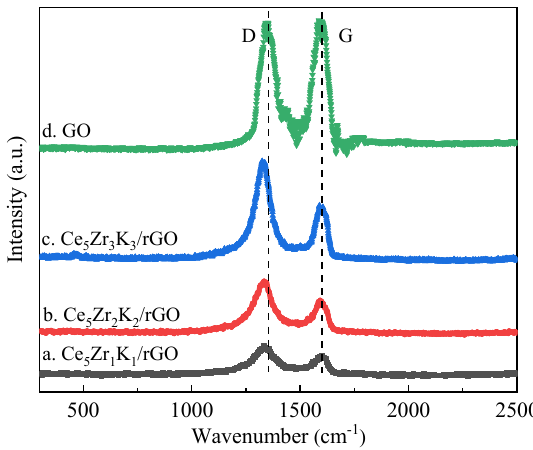
Figure 6. Raman profiles of CeZrK/rGO catalysts and graphene oxide (GO).